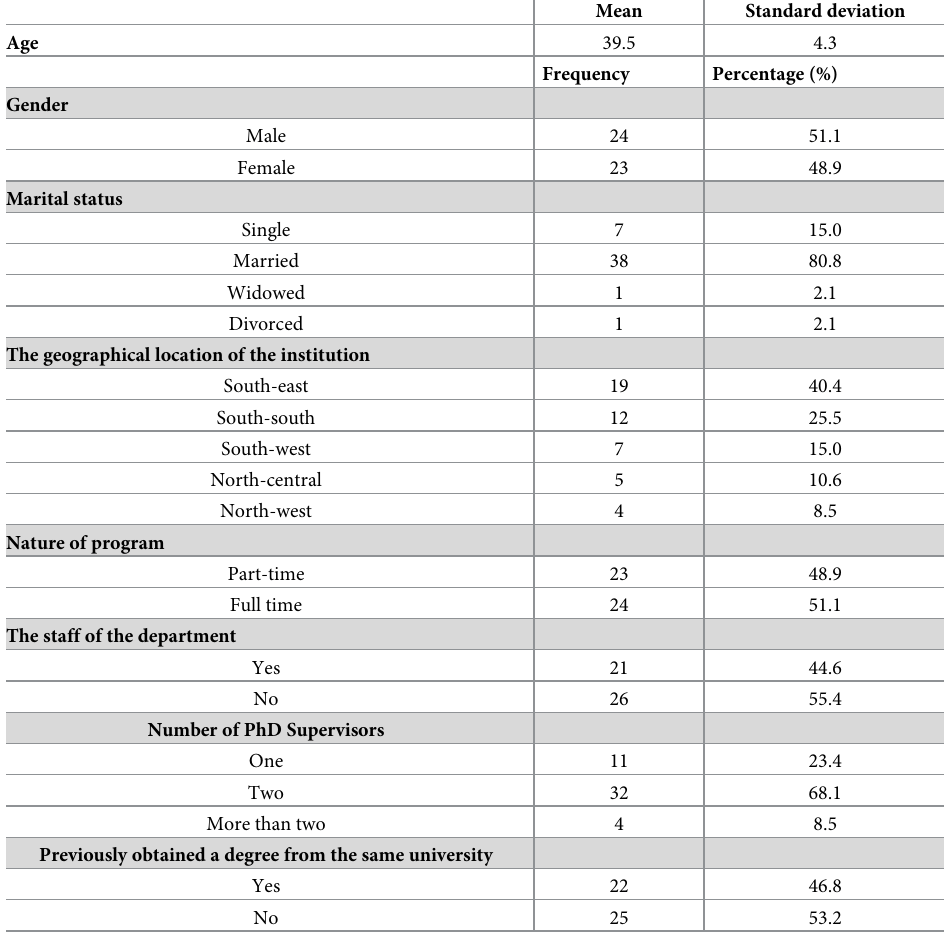
Table 1. Sociodemographic variables of the respondents (N =